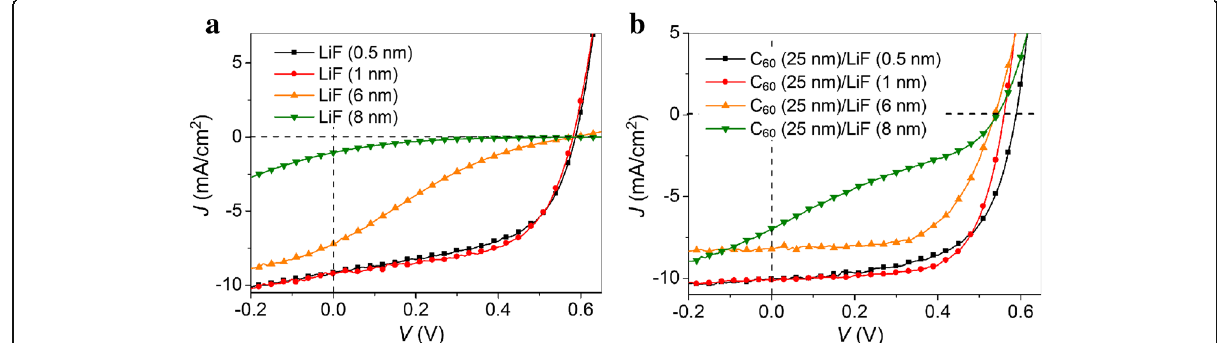
Fig. 3 J - V characteristics, recorded under 100 mW/cm 2 illumination (AM 1.5 G), of the PSCs using a LiF single and b C 60 (25 nm)/LiF double CBLs with different thicknesses of